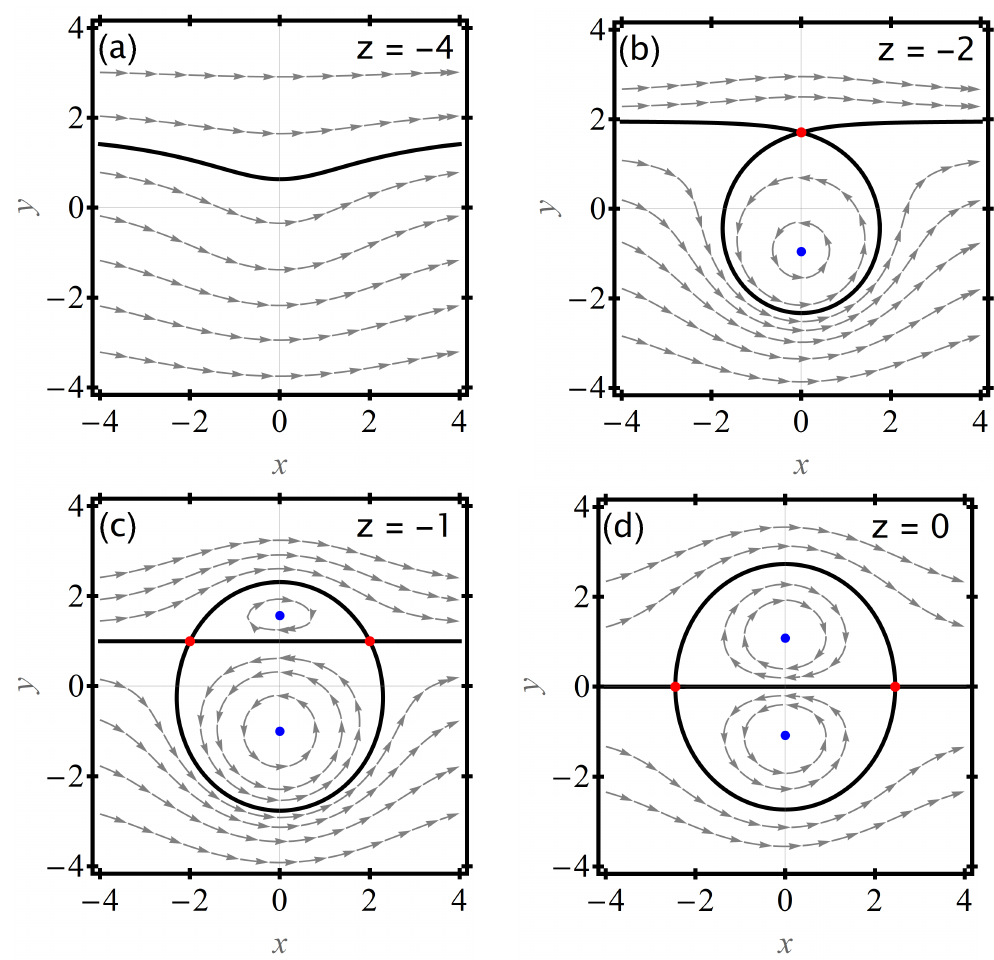
Figure 4. Phase portraits of the flow induced by a heton with Z = 1 on horizontal planes with ( a ) z = − 4, ( b ) z = − 2, ( c ) z = − 1, and ( d ) z = 0. The legend remains the same as in Figure 2, except that the separatrix is given by ψ = ψ u , where ψ u is the value of the streamfunction at an unstable fixed point. No fluid is trapped sufficiently far away from the heton ( a ), but a finite trapping region bounded by a homoclinic separatrix is seen to exist upon increasing z ( b ). Further increase in z shows the presence of a heteroclinically bound trapping region ( c ). Finally, at z = 0, the trapping region is seen to be symmetric about the x and y axes, as in the Z = 0 case ( d